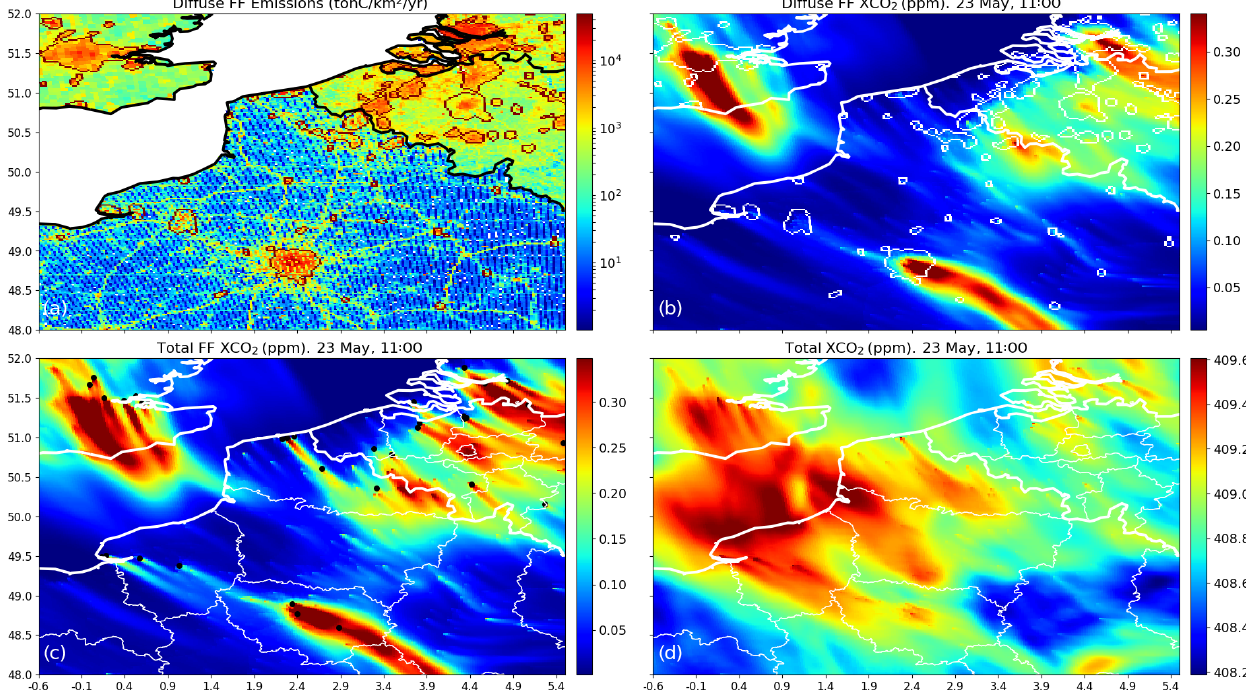
Figure 2. IER emission maps interpolated over northern France, western Belgium and the London area (a) . We have represented the anthro- pogenic emission sources without point sources (“area emissions”). Red curves depict the boundaries of the city clusters defined by a pattern recognition algorithm (Sect. 2.2.3). Panel (b) shows the simulations of XCO 2 (ppm) that are produced by the area emissions. Panel (c) shows the simulations of XCO 2 (ppm) that are produced by the total anthropogenic emissions. Panel (d) shows simulations of XCO 2 (ppm) on 23 May at 11:00LT that are produced by the combined anthropogenic, natural and boundary fluxes between 05:00 and 11:00LT. For the sake of clarity, these figures do not show the whole 2km resolution subdomain of CHIMERE; instead, they illustrate the patterns seen over this